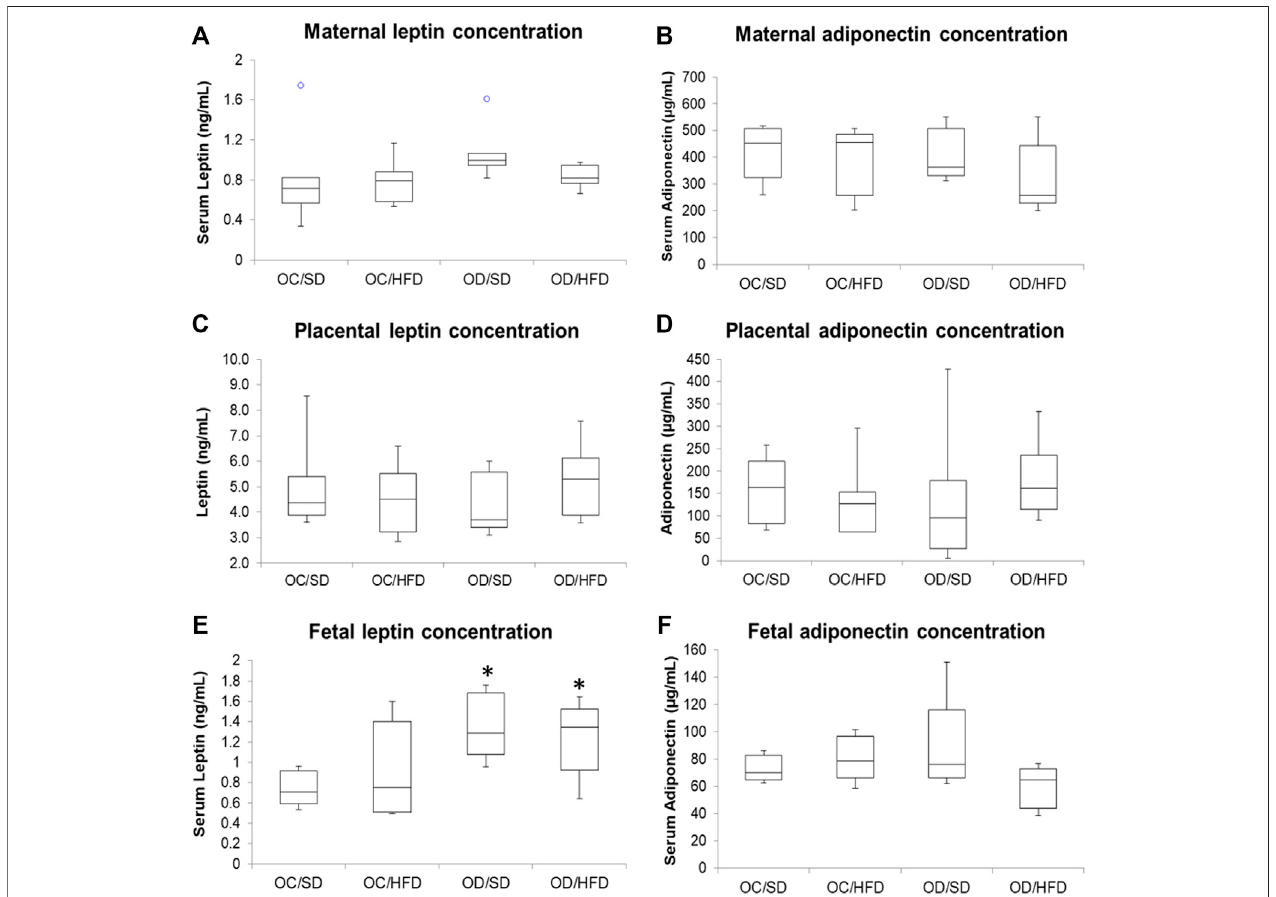
FIGURE 5 | (A) Maternal serum leptin; (B) maternal serum adiponectin; (C) placental leptin; (D) placental adiponectin; (E) fetal serum leptin; and (F) fetal serum adiponectin concentrations from control offspring (OC) and diabetic offspring (OD) that received a standard diet (SD) or high-fat diet (HFD) from weaning. Values are expressed as mean ± standard deviation (SD). n = 10 rats/group. * p < 0.05 — compared to the OC/SD group (Tukey Multiple Comparison Test). ° Purple dots represent the outliers of the respective